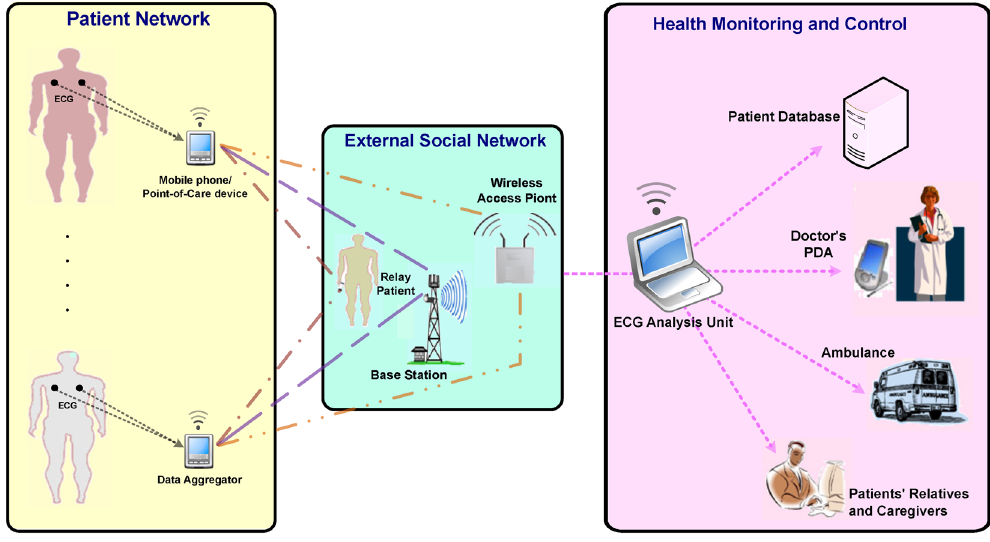
Figure 1. A wireless ECG Monitoring